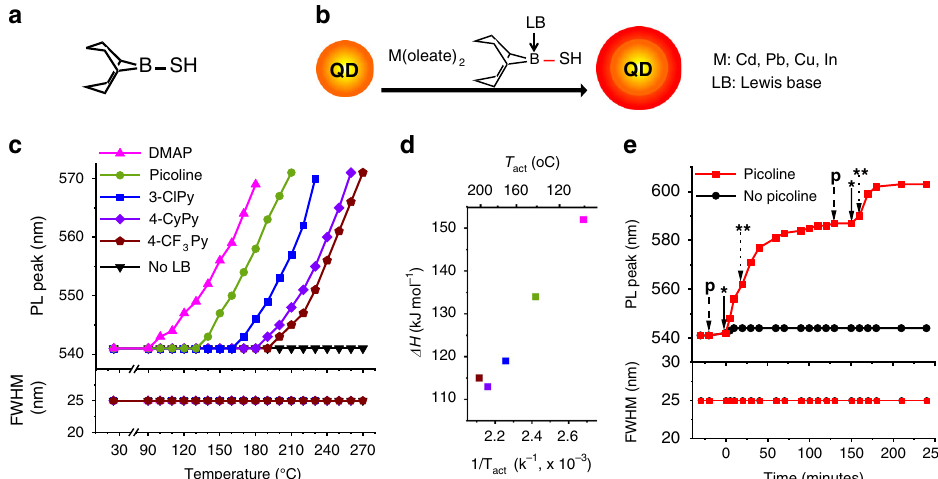
Fig. 1 Characterization of [BBN-SH:LB]-based shell growth. a Chemical structure of BBN-SH. b A schematic representation of shell deposition using BBN- SH. c Identi fi cation of the activation temperature ( T act ) of BBN-SH upon the addition of LBs by monitoring CdS shell growth. T act of BBN-SH varies with the BF 3 af fi nity of LBs: DMAP (magenta triangle), picoline (olive circle), 3-ClPy (blue square), 4-CyPy (purple diamond), and 4-CF 3 Py (brown pentagon). d LBs having higher BF 3 af fi nity ( Δ H ) yield lower T act . e LB is consumed during shell growth (p: precursor injection point, start (*) and stop (**) of picoline injection). QD emission remains tight during shell